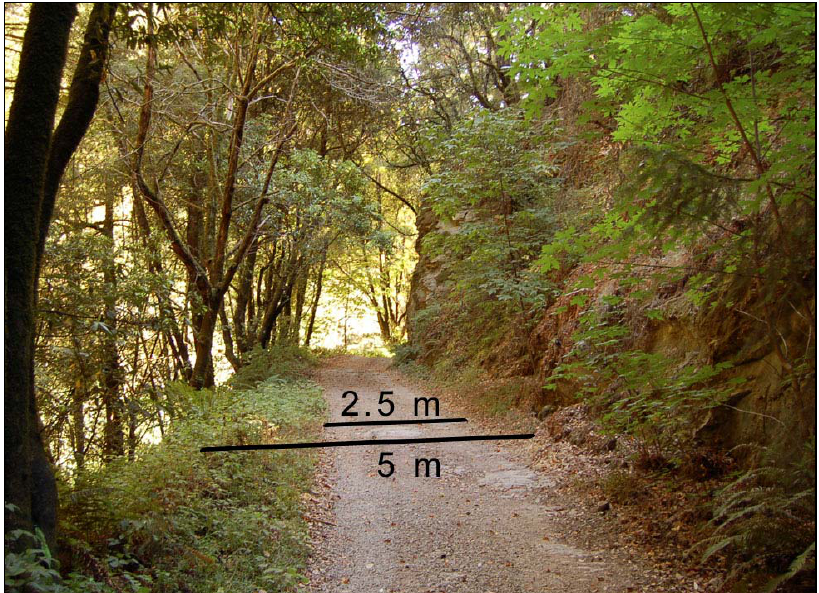
Figure 2. Little Creek road with dimensions, note the steep cut- and